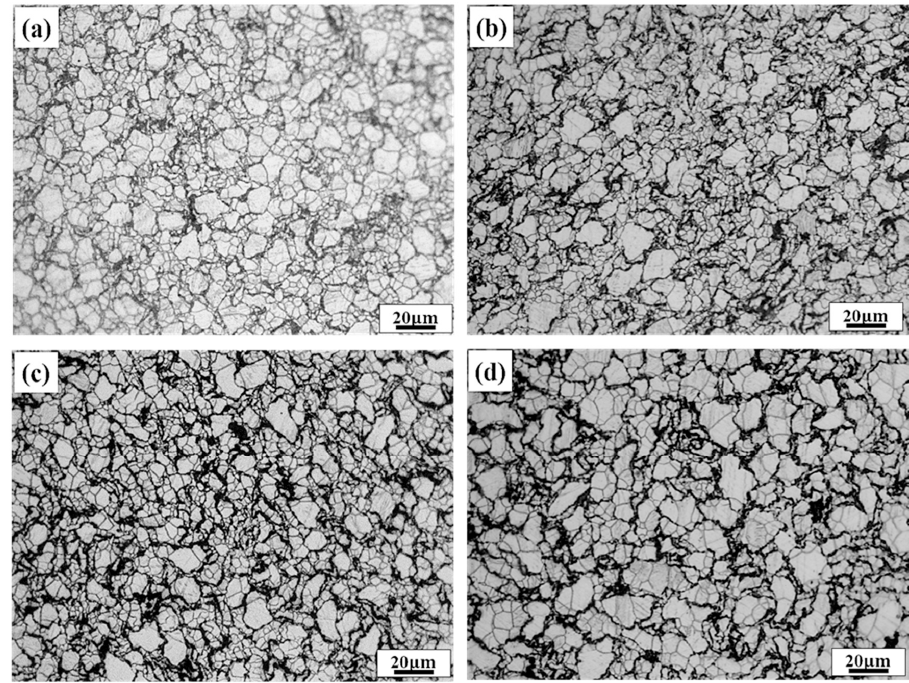
Figure 3. Optical micrographs of the AZ31 and the GNPs/AZ31 composites: ( a ) AZ31, ( b ) Figure3. OpticalmicrographsoftheAZ31andtheGNPs / AZ31composites: ( a )AZ31, ( b )0.5GNPs / AZ31, 0.5GNPs/AZ31, ( c ) 1.0GNPs/AZ31, and ( d ) 2.0GNPs/AZ31. ( c ) 1.0GNPs / AZ31, and ( d ) 2.0GNPs / AZ31. Metals 2020 , 10 , x FOR PEER REVIEW